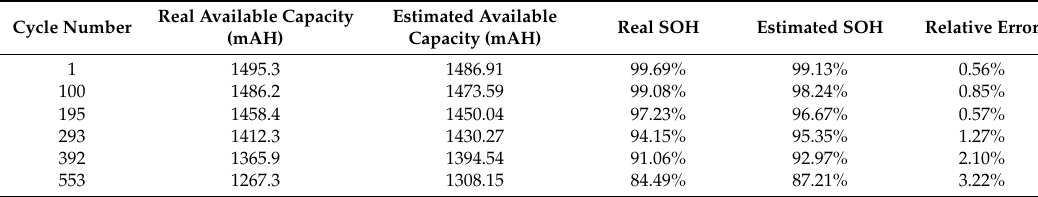
Table 6. Estimated error of method based on OCV.